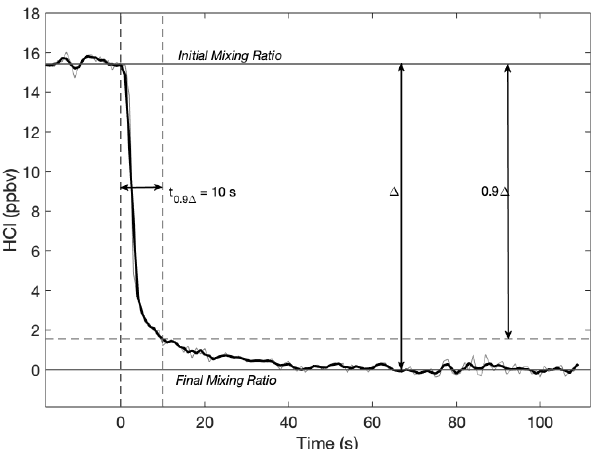
Figure 4. Response time of the HCl instrument when 15.5ppbv HCl was replaced with ultra-zero air flow. The observed mixing ratio is 10% of the input value after 10s. The light grey line is 1Hz sampling. The black line is a 3s smoothing average. The cell was heated to 315K, and cell pressure was